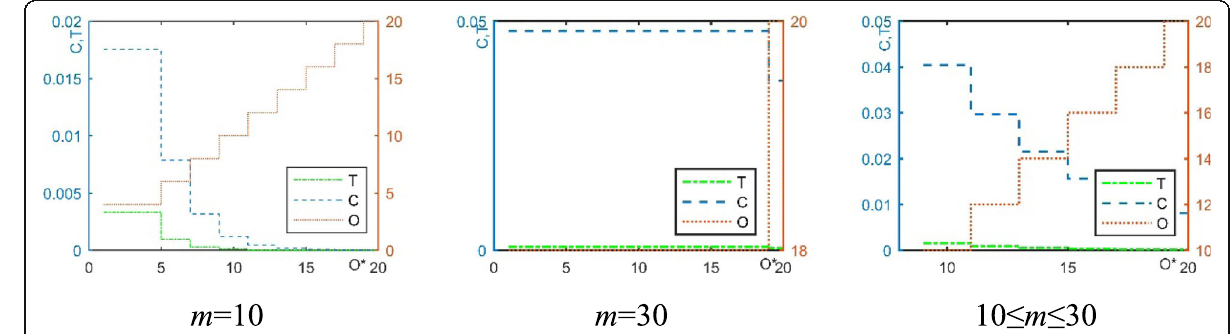
Fig. 7 Relationship among data security, data survivability, and user storage overhead under various O* constraints for n = 30 and C * =